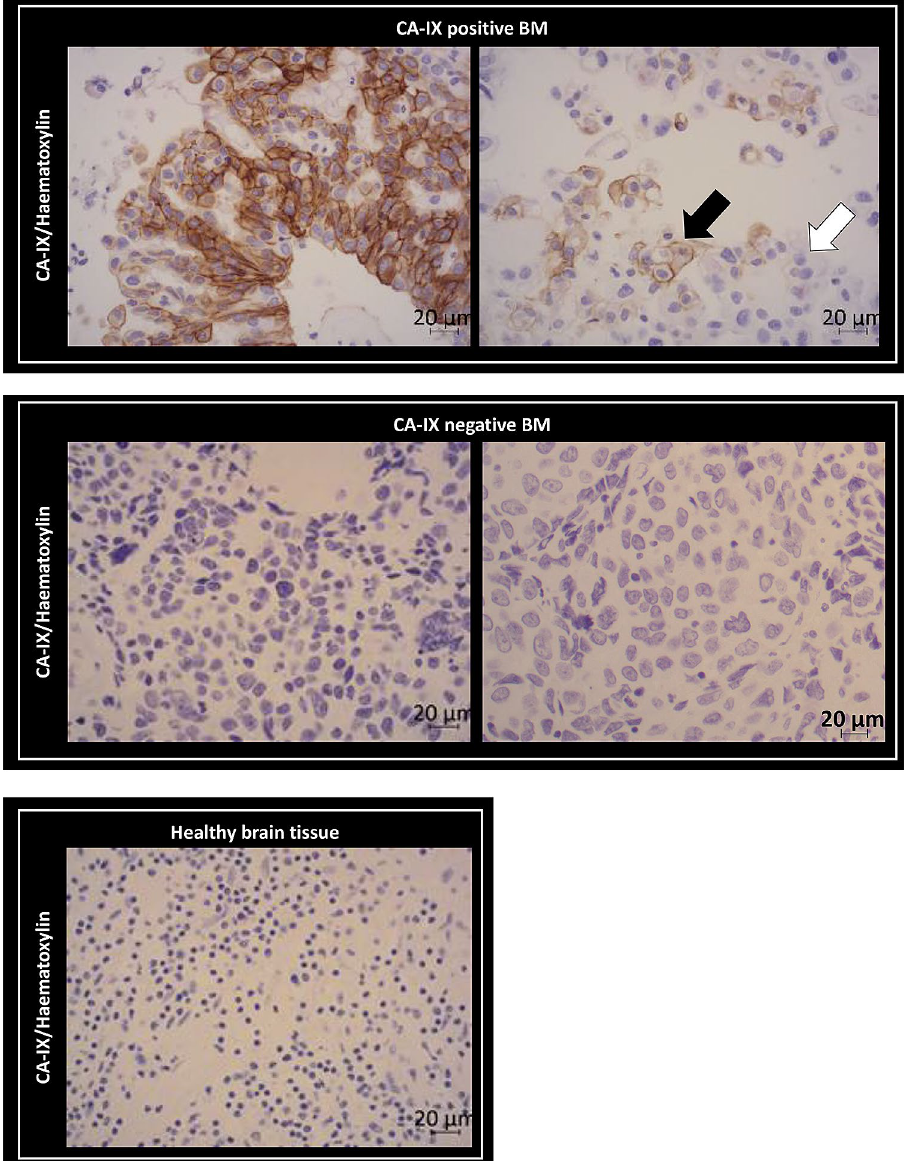
Figure 2. Characterization of hypoxia in human BM biopsies from primary lung cancer by immunohistochemistry. Representative images of CA-IX staining (brown) with hematoxylin counterstaining (purple) on four BM biopsies from four patients with primary lung adenocarcinoma and one healthy